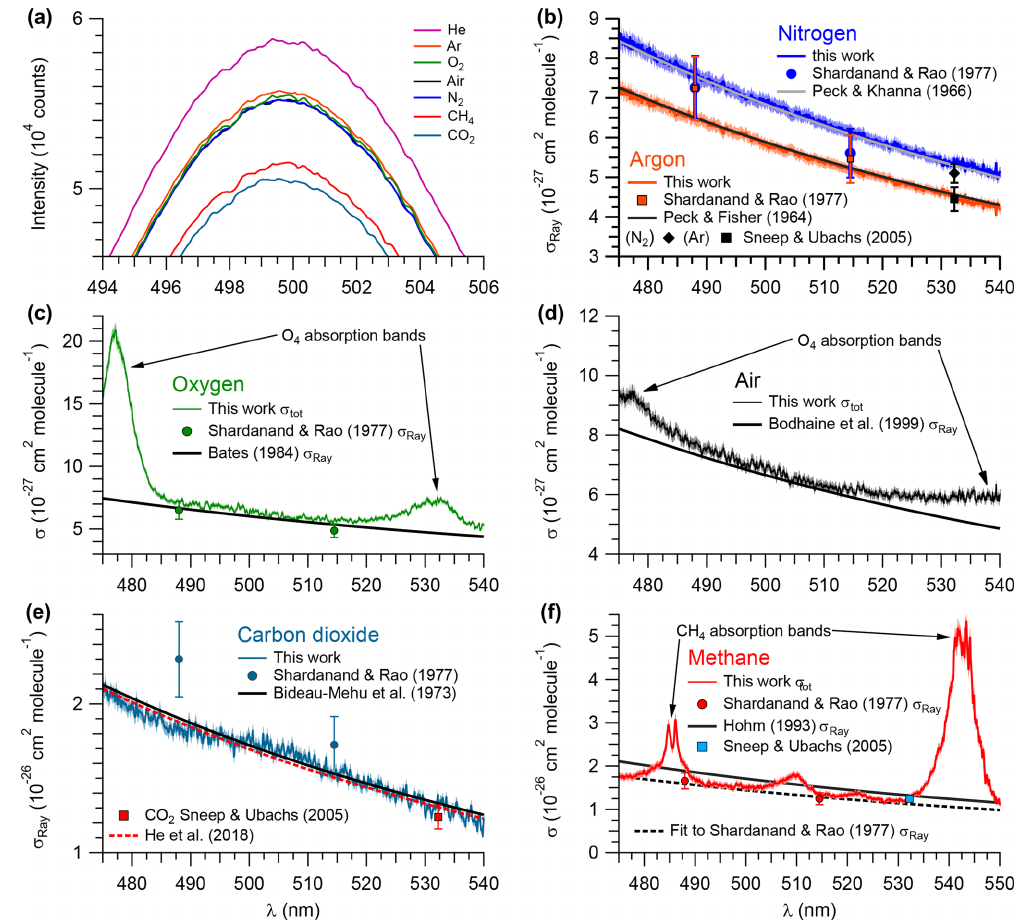
Figure 4. Measurements of pure gases. (a) Relative intensities of the IBBCEAS signal due to each sampled gas. Extinction cross sections of (b) 99.998% N 2 (shown in blue) and 99.998% Ar (red), (c) air (black), (d) 99.99% O 2 (green), (e) 99.95% CO 2 (teal), and (f) 99.97% CH 4 (red). Shaded areas represent ± 2 . 5% error margin in N 2 , Ar, O 2 , air, and CO 2 , and 4.6% in CH 4 . σ Ray – Rayleigh scattering cross section; σ tot – total extinction cross section (i.e., σ Ray + σ abs